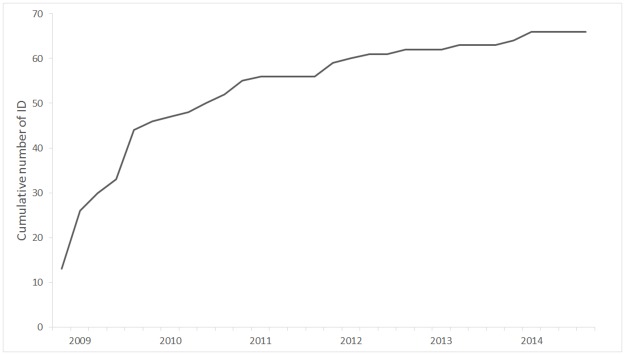
Cumulative number of newly identified individual dolphins [marking levels (2) and (3)], by secondary period (June–October), from 2009 to 2014, off the west coast of Reunion.